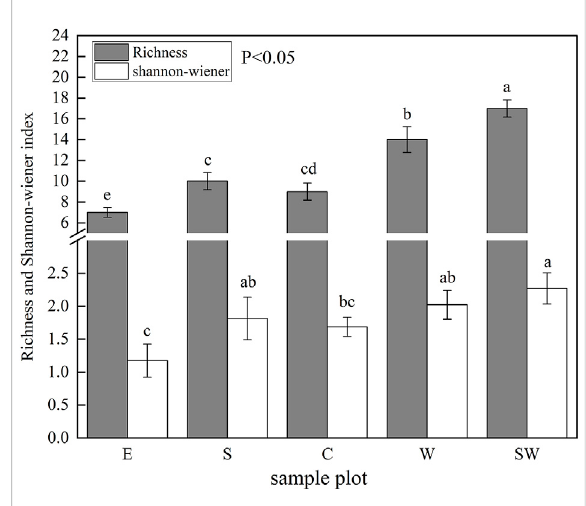
FIGURE 4 Two-way indicator species analysis classi fi cation results of vegetation. N is the number of sample plots for classi fi cation, and Di (i = 1, 2, 3...9) represents the sequence of division. Roman numerals correspond to the plant communities in the fi ve plots in sequence (Figure 1).